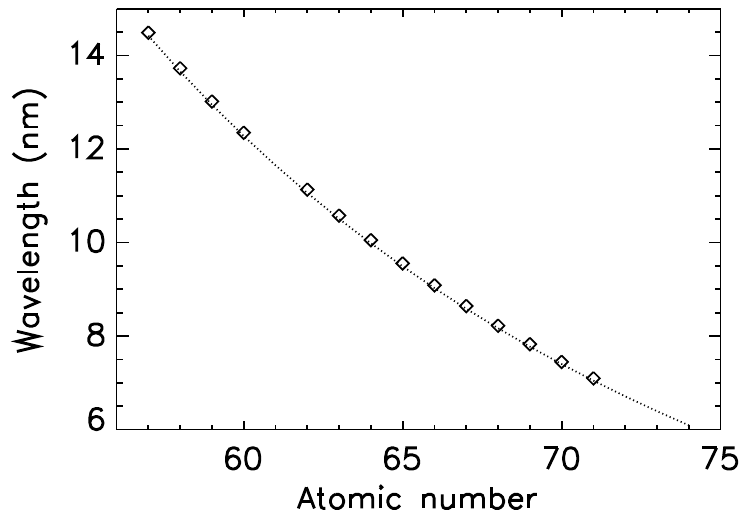
Figure 2. Z dependence of the transition wavelength from ((4s, 4p − ) 1 , 4p + ) 3/2 to the ground state (line a in Figure 1a) of Ga-like ions. The wavelengths measured in LHD plasmas are shown by diamonds, while the calculated wavelength is drawn by a dotted